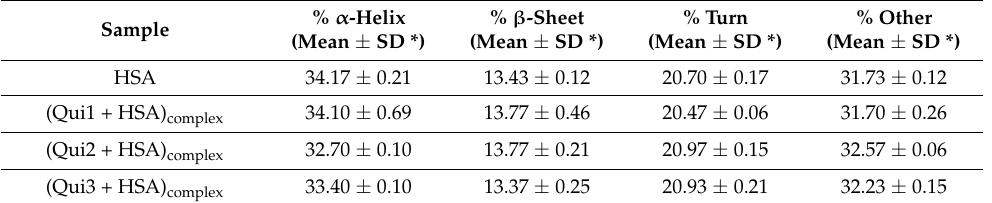
Table 4. The percentage (%) content of the secondary structure elements of HSA in the absence (HSA) and presence of ligands (Qui1–Qui3); Young’s reference